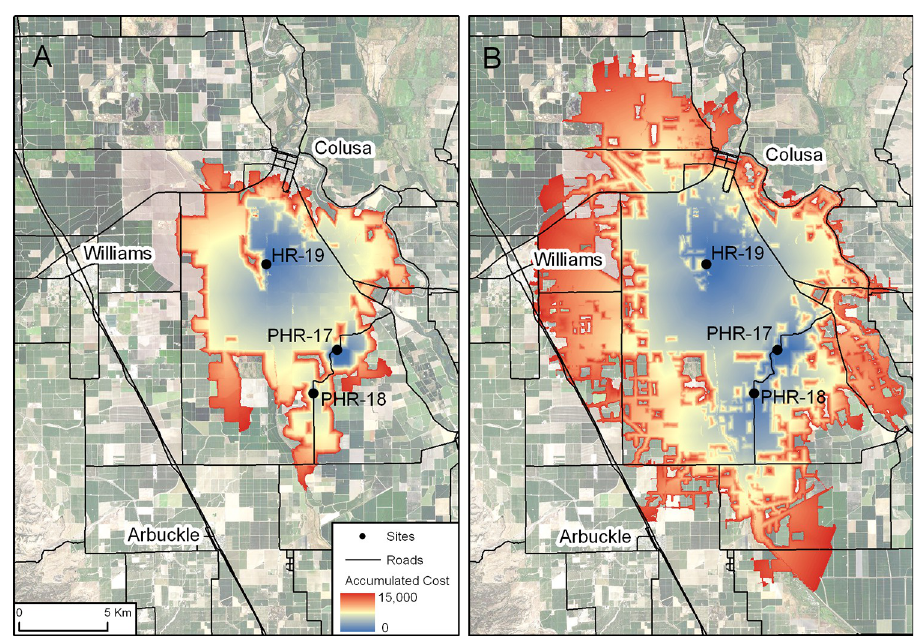
Fig 7. Close-up image showing cumulative costs incurred as a function of distance moving outward from three source points (yellow dots) for A) the current conditions with moderate resistance and B) the scenario in which all agricultural margins are converted to natural habitat with moderate resistance for the other land cover classes. Red colors indicate a low cost of movement (i.e. high probability of connectivity with the source points) and blue colors indicate a movement cost approaching 15,000 cost-distance units (number of cells traversed x cost of moving over the cell).